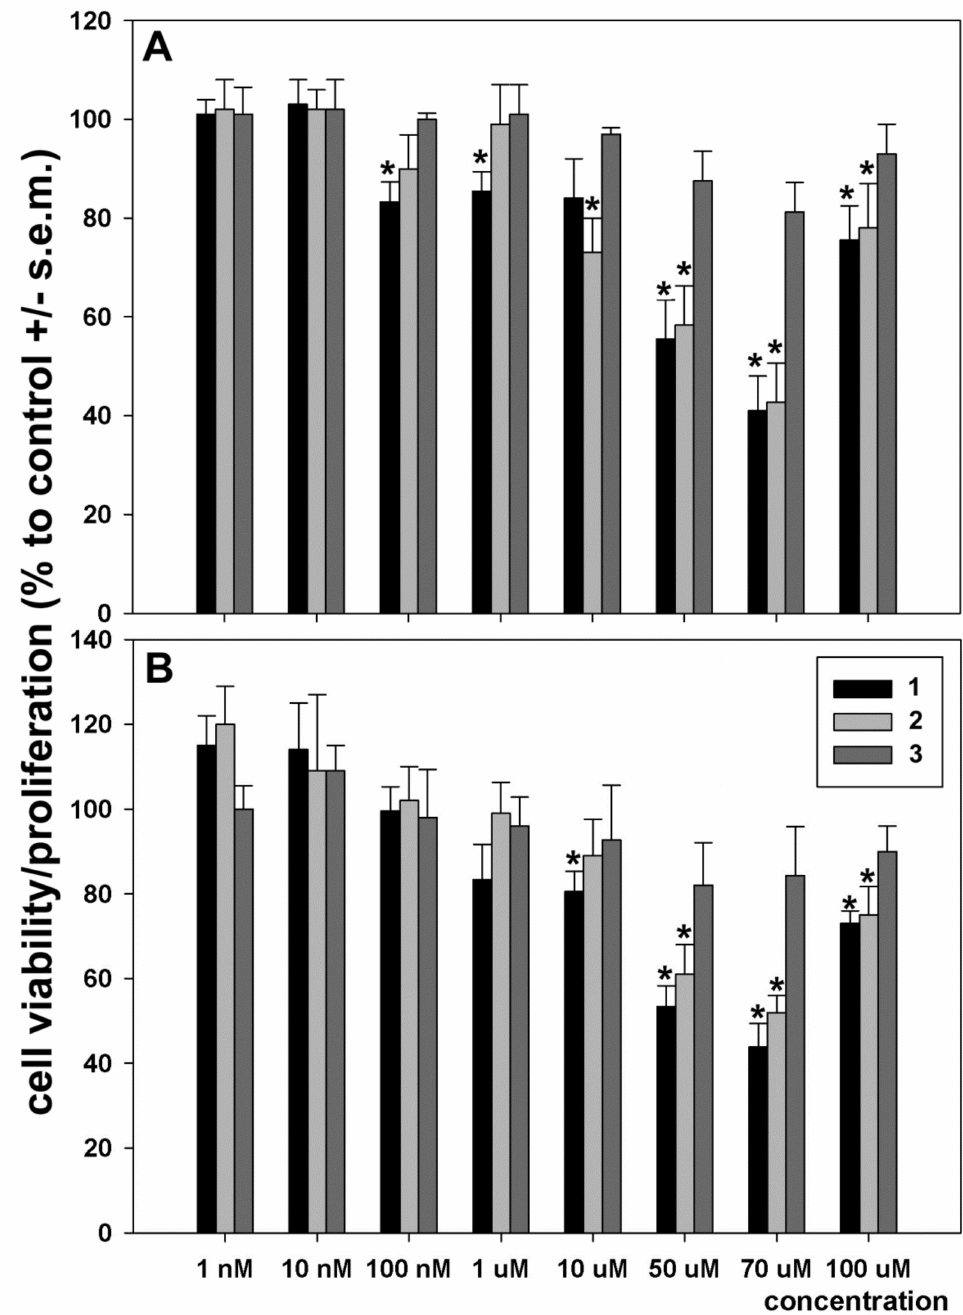
Figure 2. Effect of 24 h incubation with 1 , 2, and 3 on the viability of MDA-MB-231 cells. ( A ) Dose–response bars from quadruplicate cell counting assays. ( B ) Dose–response bars from quadruplicate MTS assays. Four replicates were run for each assay. The results are expressed as the mean ± standard error of the mean (SEM). * p <